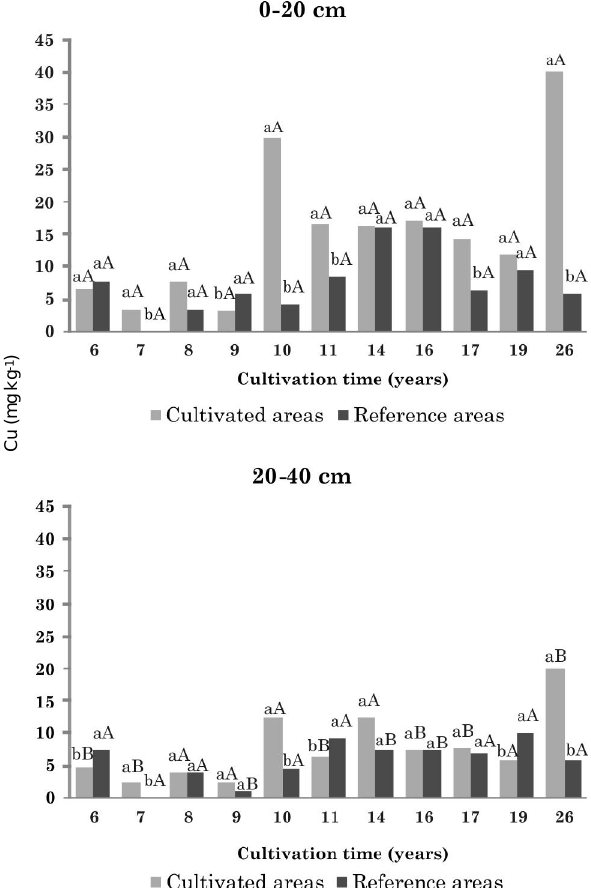
Figure 1. Total Cu contents in cultivated (CA) and reference areas (RA) in two layers (0-20 and 20- 40 cm) after different cultivation periods. Means followed by lowercase letters between environments (CA and RA) and capital letters between layers (0-20 and 20-40) did not differ statistically by Tukey´s test (p (cid:172)(cid:31)(cid:172)